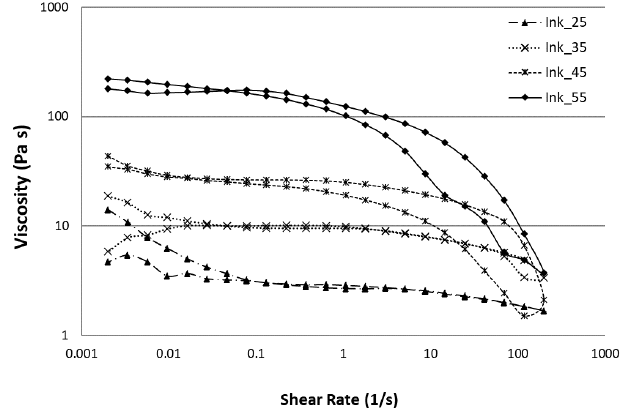
Figure 3. Flow curves of the formulated CuO inks.